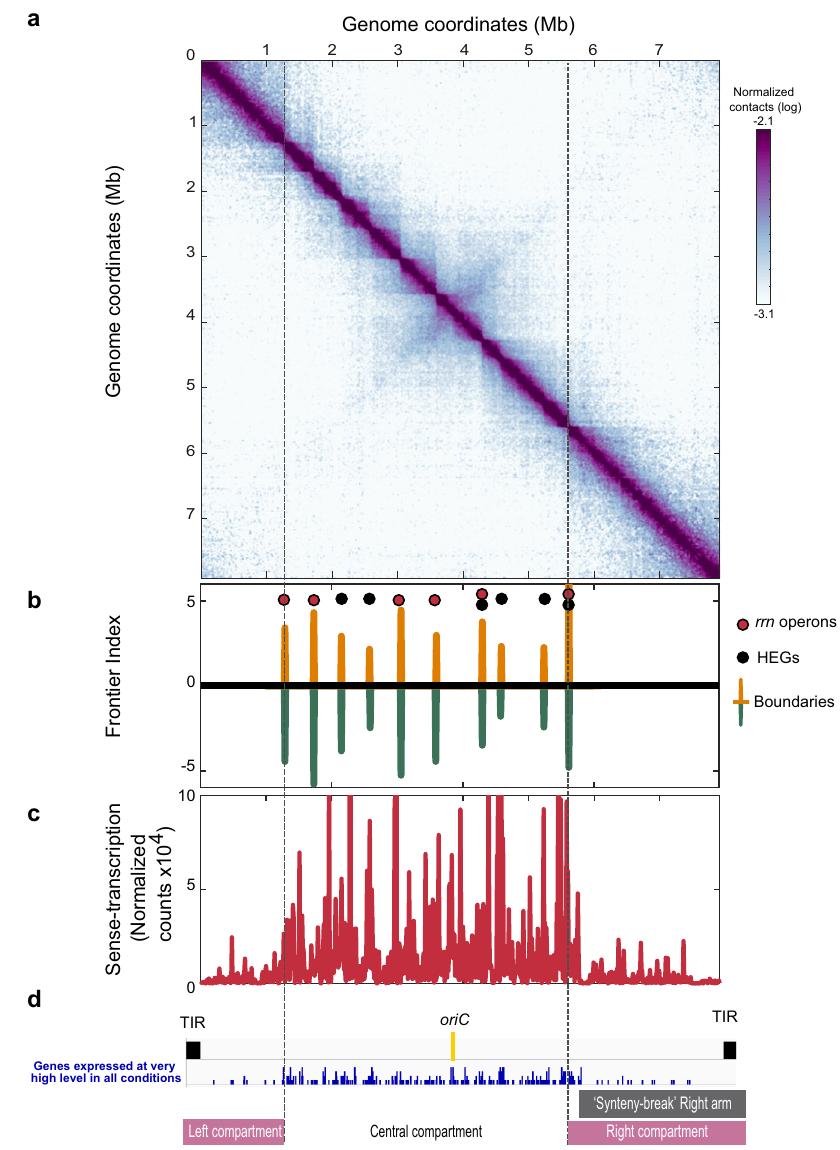
Fig. 3 Spatial organization of S. ambofaciens chromosome and transcriptome in absence of metabolic differentiation. 3C-seq and RNA-seq were performed on S. ambofaciens grown in exponential phase in YEME10 medium (24 h, C6 condition). a The normalized contact map was obtained from asynchronous populations. The x and y axes represent the genomic coordinates of the reference genome. To simplify the analyses, TIRs were removed from the reference genome. The color scale re fl ects the frequency of the contacts between genome loci, from white (rare contacts) to dark purple (frequent contacts). In b , the frontier index analysis is able to detect, for a given genome 10 kb bin, the change in the contact bias with their neighboring bins. Thus, a boundary is de fi ned as any bin in which there is a change in the right bias of contacts towards the left bias (±2 bins, green and orange peaks, respectively). Red and black circles indicate the position of rDNAs ( rrn ) and highly expressed genes (HEGs), respectively. In c , the DESeq2 normalized counts measured in cells grown in the same condition were mapped on S. ambofaciens chromosome and binned in 10 kb. d The panel highlights genomic and transcriptional features of interest. The right and left compartments were de fi ned owing to the outer boundaries of the central compartment, which correspond to the fi rst and last rDNA operon position (vertical lines). The ‘ synteny break right arm ’ corresponds to the beginning of the spiramycin BGC. The replicate of this experiment is presented in Supplementary Fig.